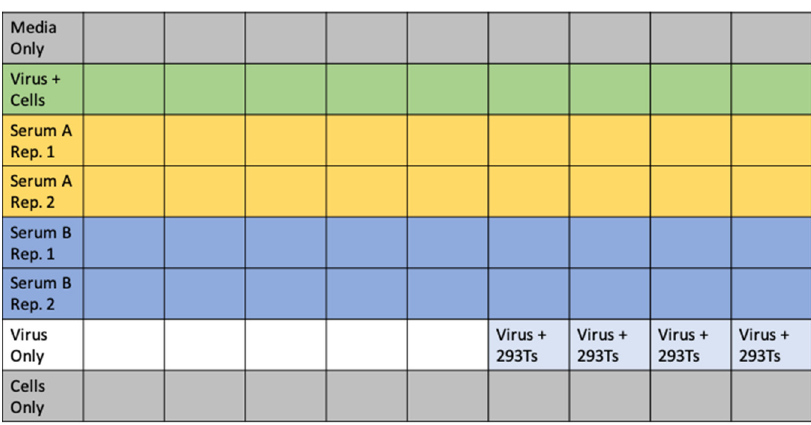
Figure 5. Example plate layout for neutralization assays. It is possible to run full-dilution series of two sera or plasma samples in duplicate on each plate with the necessary controls. These controls include media only, cells only, and virus-only wells, as well as four wells of virus-infecting 293T cells to confirm the lack of infection with Spike-pseudotyped lentivirus in the absence of ACE2. The average signal from the “Virus Only” and “Virus + 293Ts” wells provides the background signal. The “Virus + Cells” wells represent maximum infection without any serum and provide a metric for 100% virus infectivity. Note that “cells” here refers to the 293T-ACE2 cells. The di ff erent colors simply denote di ff erent conditions, such as di ff erent serum samples or cells. These conditions are labeled in the left-most column of the figure (or in each individual cell for the “Virus + 293Ts” condition).